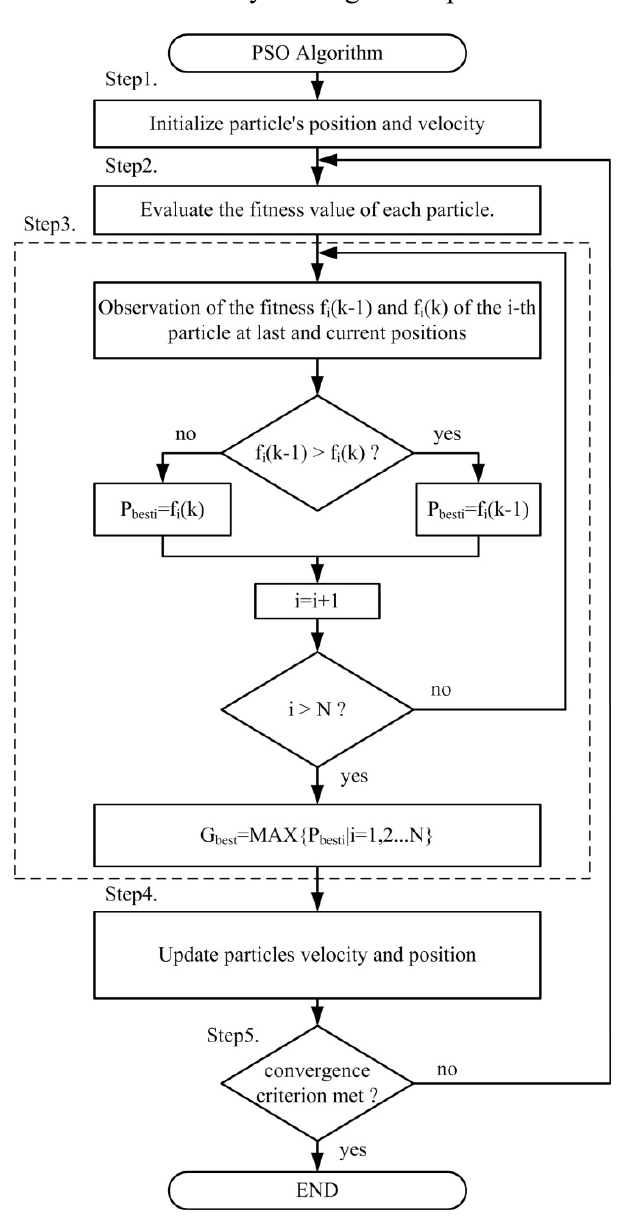
Figure 9. Flowchart of a standard